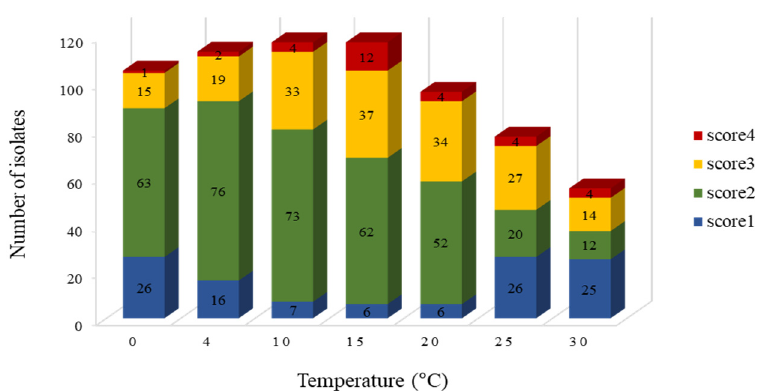
Figure 2. Effect of temperature on bacterial growth. The degree of growth was scored from 1 to 4, with a higher number indicating better growth.